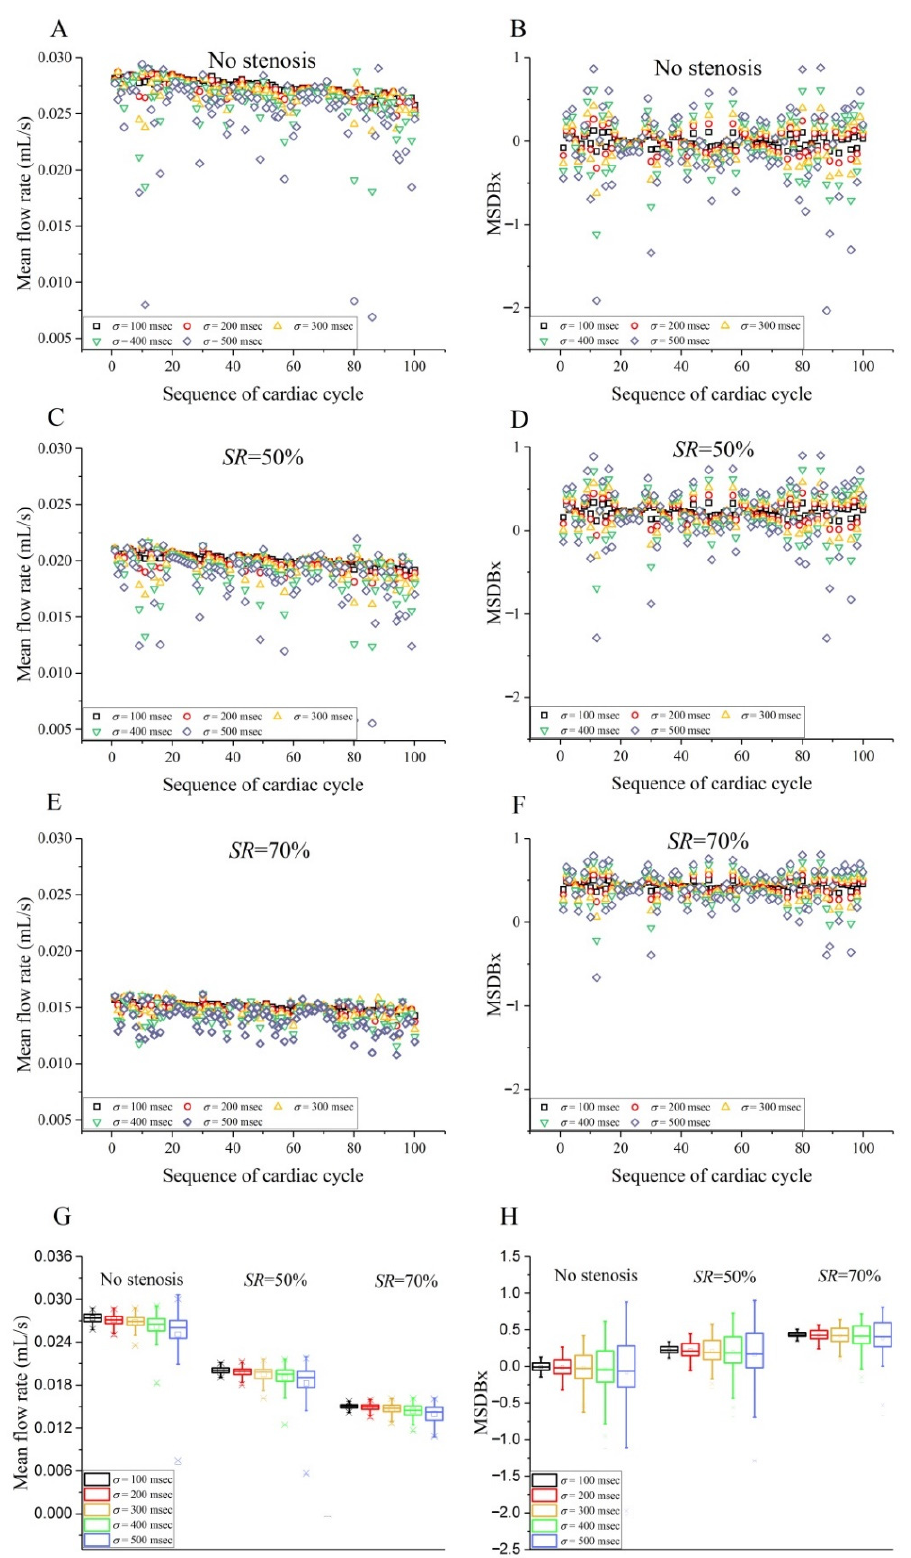
Figure 6. Scatter plots of cardiac cycle-specific mean coronary artery blood flow rates ( A , C , E ) and MSDBxes ( B , D , F ) during 100 cardiac cycles with various severities (controlled by the value of σ ) of R-R interval irregularity when the coronary artery is normal (no stenosis) or has a 50% or 70% stenosis. The statistical box plots of mean flow rates and MSDBxes computed for each set of 100 cardiac cycles are presented in panels ( G , H ),